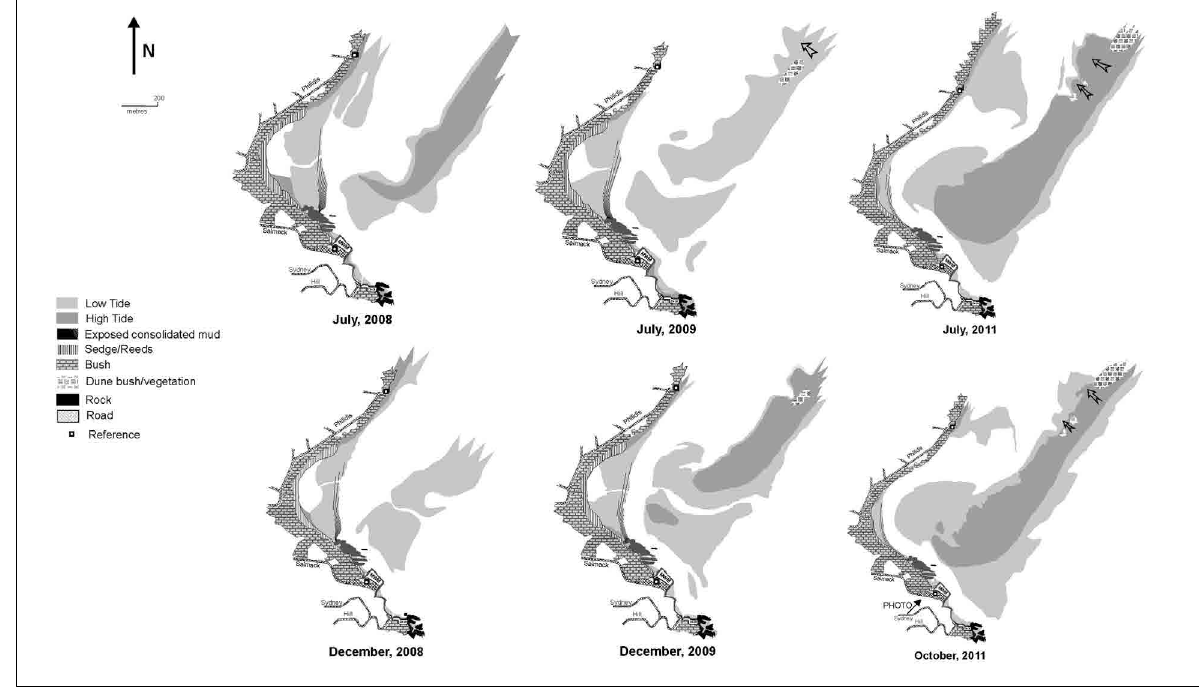
Figure 7: Sediment structures in the Keurbooms Estuary on the given dates. The arrows on the barrier dune indicate washover